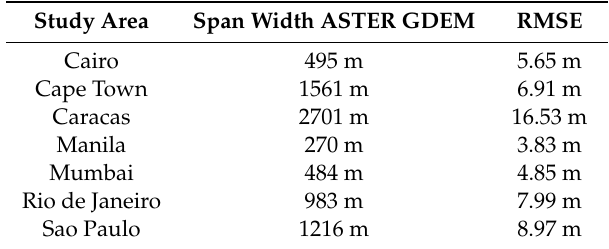
Table 3. Root Mean Squared Error (RMSE) of filtered ASTER GDEM.